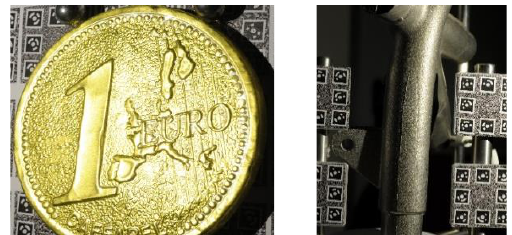
Figure 1. Two examples of non- collaborative objects considered in this